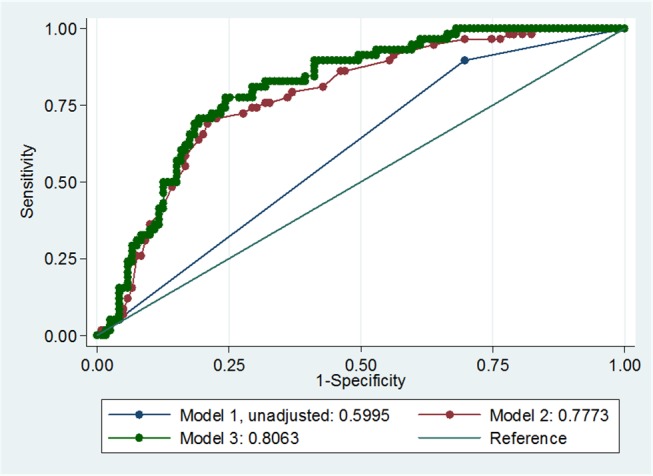
The intensity of INR and MVO- Predictability of the models.